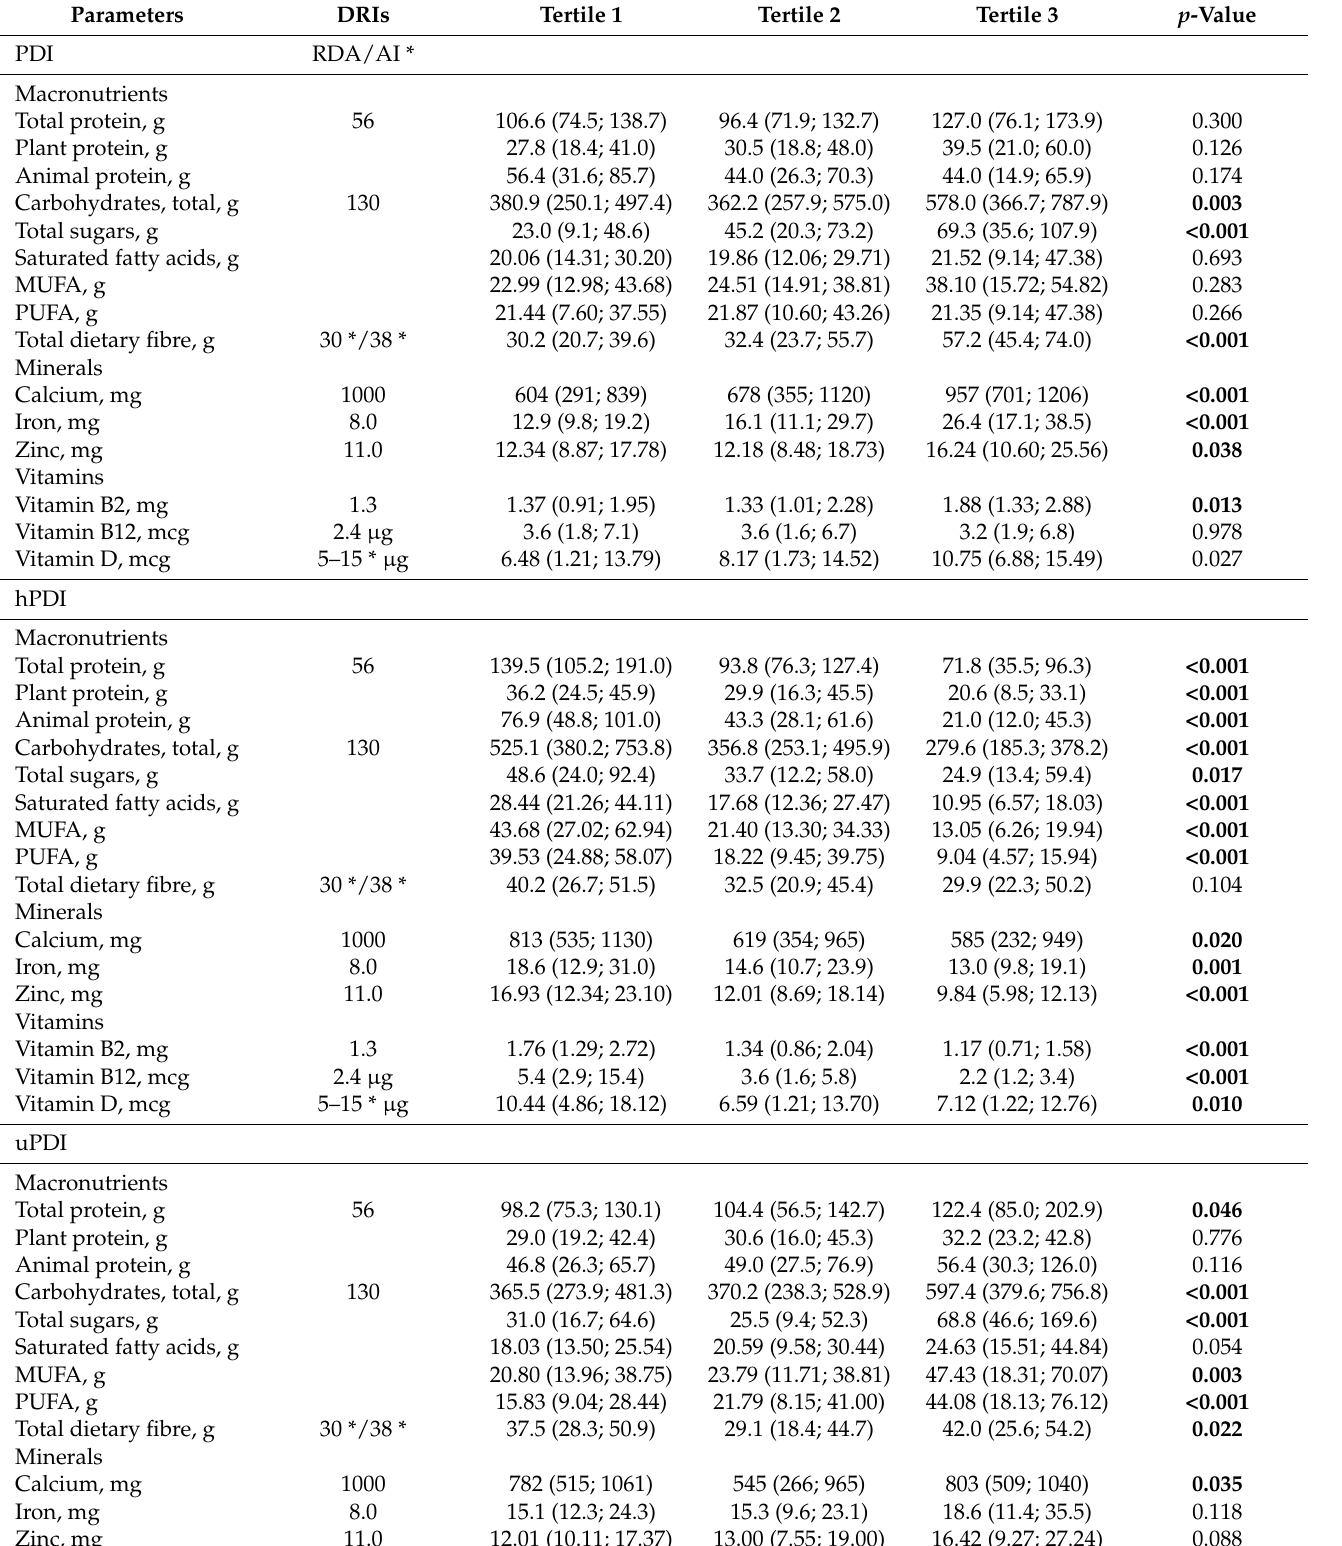
Table 3. Distribution of dietary characteristics of the PBD